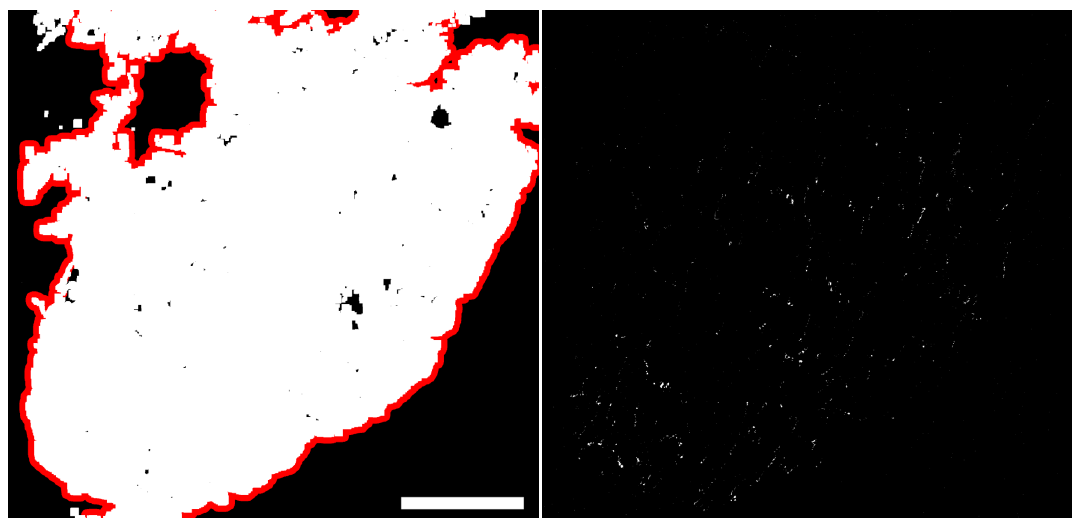
Figure 10. Left: Tissue mask M t represented in white, enclosed by maximum contour in red, for image a . Right: Equalized and binarized channel M c 4 ( thr c 4 = 254) for the same image. Scale bar = 100 µ m.